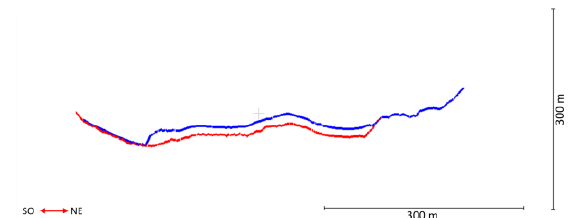
Figure 15. Comparison between 2014 DPCs (in blue) and 2016 DPC (in red) along Section